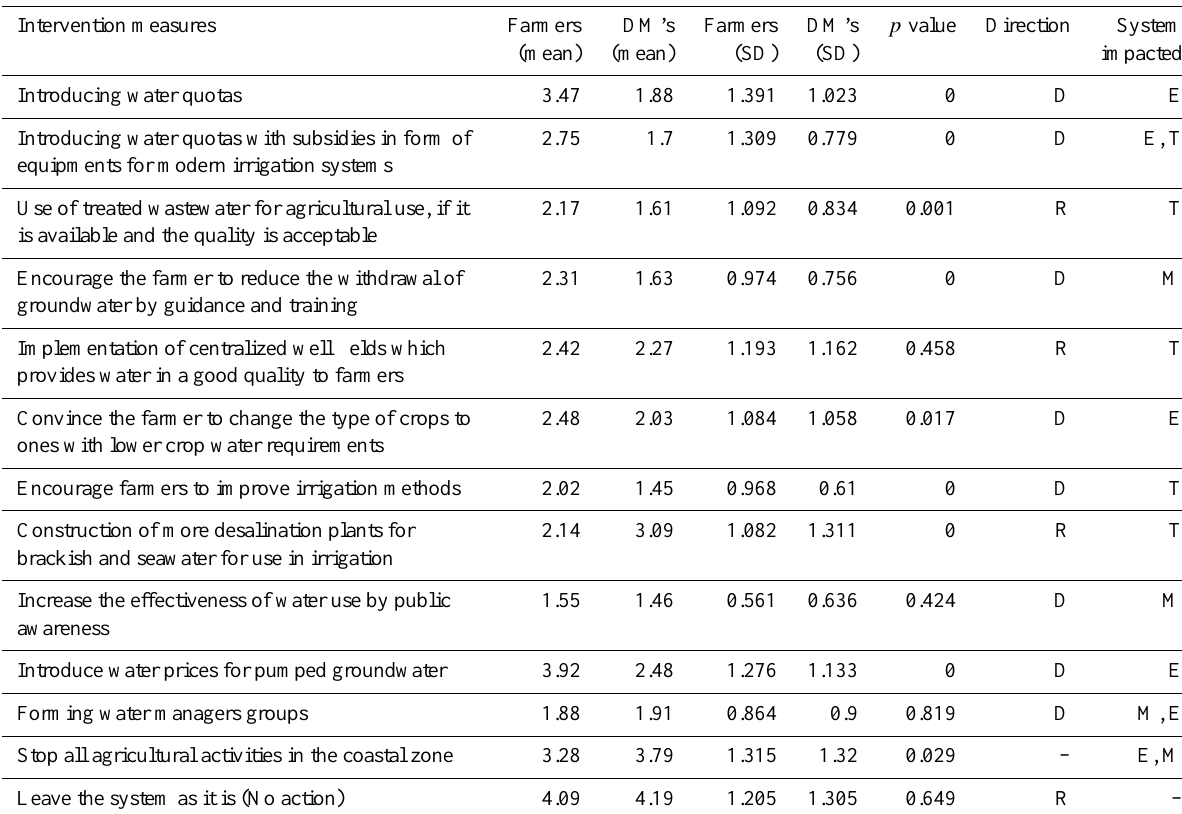
Table 1. Selected results of a social survey for potential management interventions. Intervention